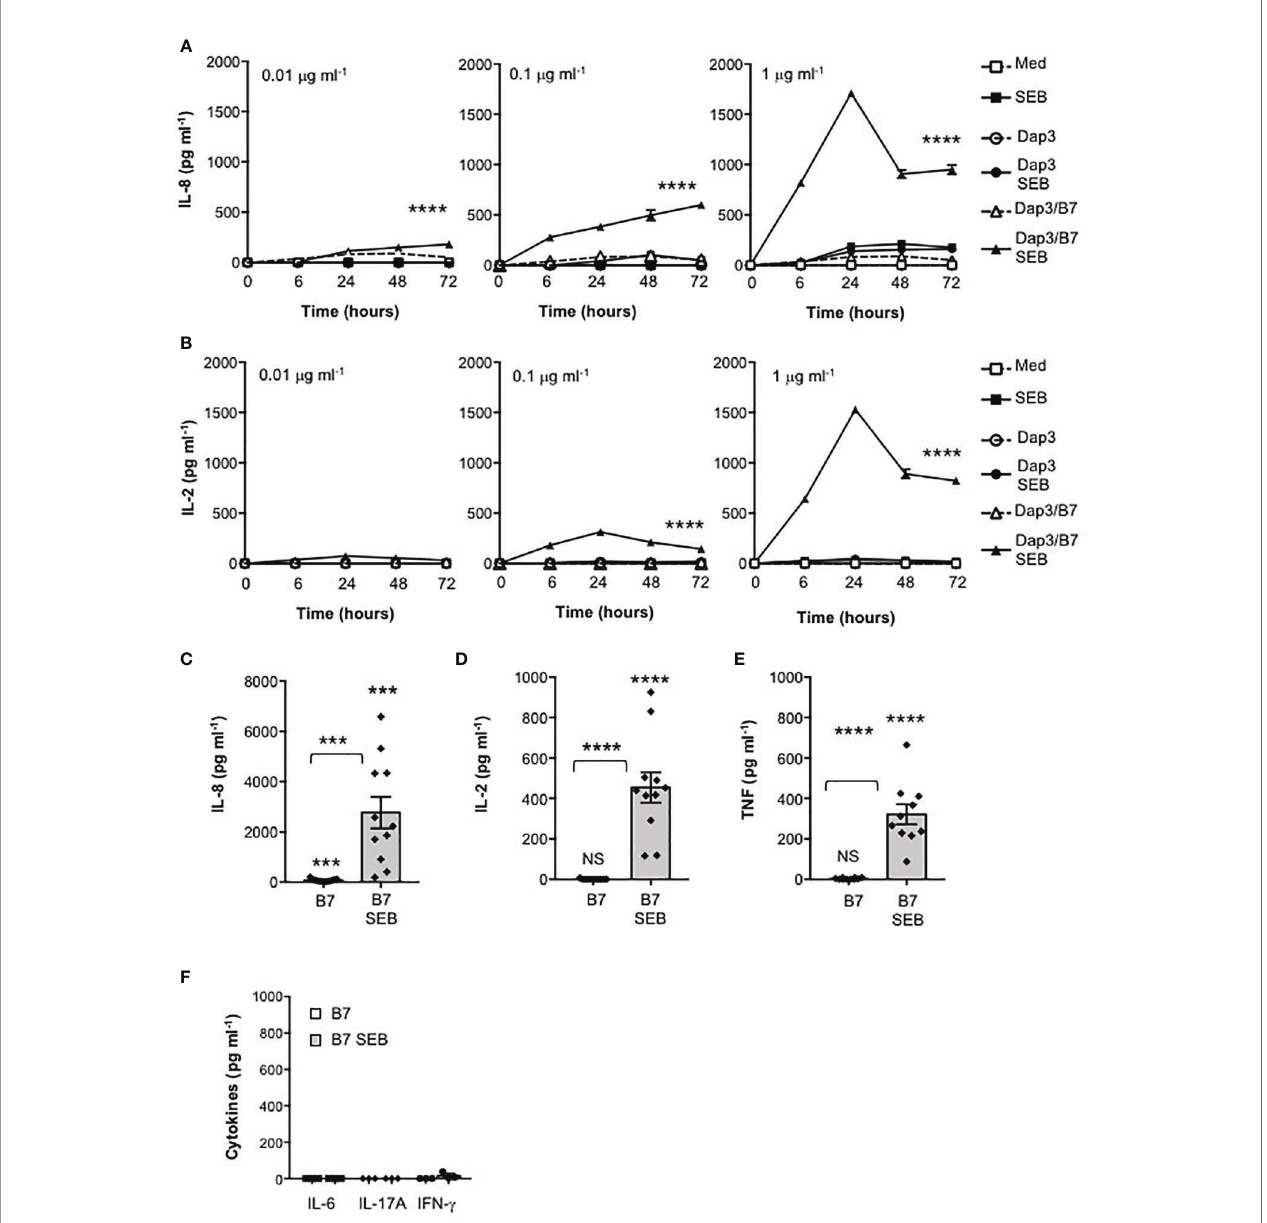
FIGURE 1 | Stimulation of CD28 by SEB induces the secretion of pro-in fl ammatory cytokines and chemokines in the absence of MHC class II molecules. (A, B) CH7C17 Jurkat cells expressing human CD28WT were stimulated for the indicated times with murine L cells (Dap3) or Dap3 expressing human B7.1/CD80 (Dap3/B7) in the presence or absence of different doses of SEB. IL-8 (A) and IL-2 (B) levels in culture supernatant were measured by ELISA. Data show the mean ± SEM of one out of three independent experiments. Statistical signi fi cance was calculated by 2-way ANOVA test. (C – F) CD28WT cells were stimulated for 24 hours with Dap3/B7 in the absence or presence of 1 m g ml -1 SEB. (C) IL-8 (n = 11), (D) IL-2 (n = 11), (E) TNF (n = 10), (F) IL-6, IL-17A and IFN- g (n = 3) levels in culture supernatant were measured by ELISA. Data show the mean ± SEM and statistical signi fi cance was calculated by Student ’ s t test. Means values: IL-8, medium (med) = 1.7 pg ml -1 , B7 = 76 pg ml -1 , B7 SEB = 2767 pg ml -1 ; IL-2, med = 0 pg ml -1 , B7 = 0.6 pg ml -1 , B7 SEB = 454.4 pg ml -1 ; TNF, med = 4.1 pg ml -1 ; B7 = 3.3 pg ml -1 , B7 SEB = 321.6 pg ml -1 ; IL-6, med = 0 pg ml -1 , B7 = 0 pg ml -1 , B7 SEB = 0 pg ml -1 ; IL-17A, med = 0 pg ml -1 , B7 = 0 pg ml -1 , B7 SEB = 0 pg ml -1 ; IFN- g , med = 0 pg ml -1 , B7 = 0 pg ml -1 , B7 SEB = 16.5 pg ml -1 . (***) p < 0.001, (****) p < 0.0001, NS, not signi fi